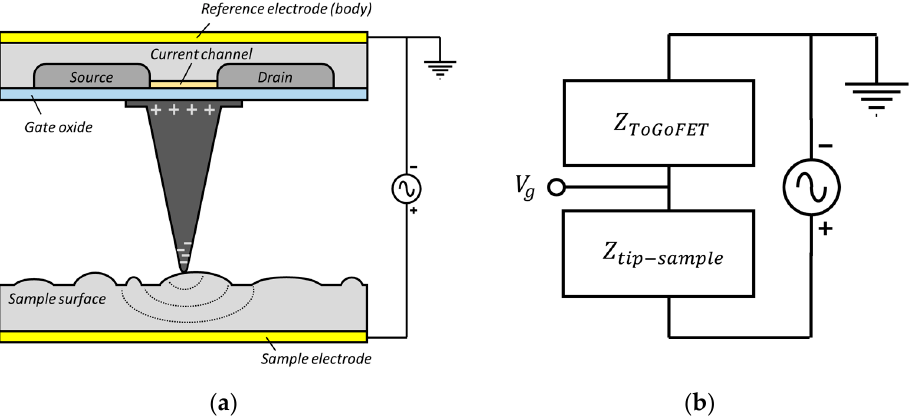
Figure 1. ( a ) Schematic of the ToGoFET probe in contact with the sample surface. ( b ) Equivalent circuit model of the tip-sample system.